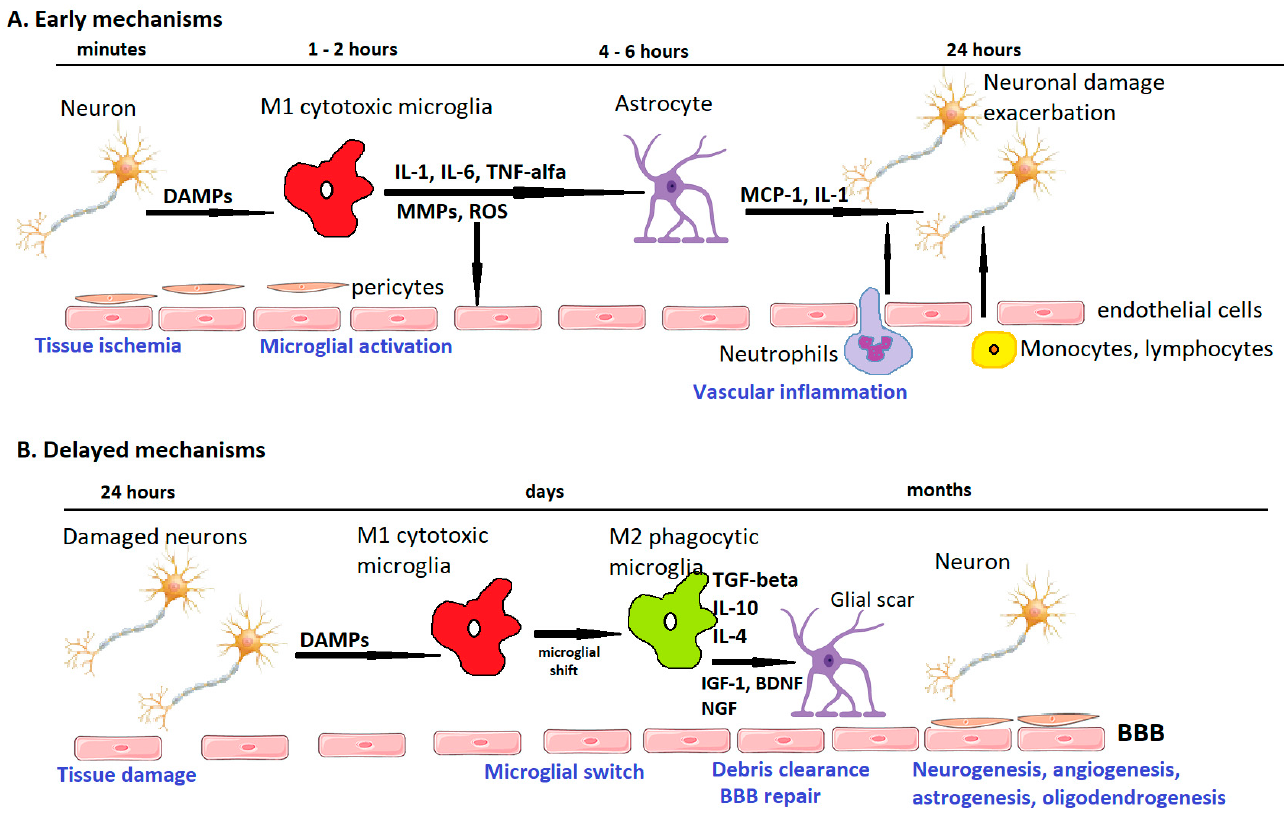
Figure 2. Temporal profile of post-stroke ischemic pathways. Immediately after ischemic stroke, neurons release damage-associated molecular patterns (DAMPs) which lead to microglial and endothelial activation. M1-polarized microglia release pro-inflammatory interleukins (IL-1, IL-6, tumor necrosis factor-alpha), as well as matrix metalloproteinases (MMPs) and reactive oxygen species (ROS), which weaken the blood–brain barrier (BBB). Pericytes and astrocytic endfeet are lifted from the basement membranes. A “leaky” BBB allows leukocytes to infiltrate the cerebral parenchyma, where they produce pro-inflammatory factors (IL-1, monocyte chemotactic protein 1 (MCP-1)) and exacerbate tissue injury. In the delayed subacute phase, microglial switch to an M2 phenotype leads to tissular debris clearance, and, by expressing anti-inflammatory mediators and neurotrophic factors such as insulin-like growth factor 1 (IGF-1), brain-derived neurotrophic factor (BDNF), or nerve growth factor (NGF), promotes glial scar formation as well as BBB repair, neurogenesis, astrogenesis, oligodendrogenesis, and angiogenesis. Adapted from Rajkovic et al. [204].